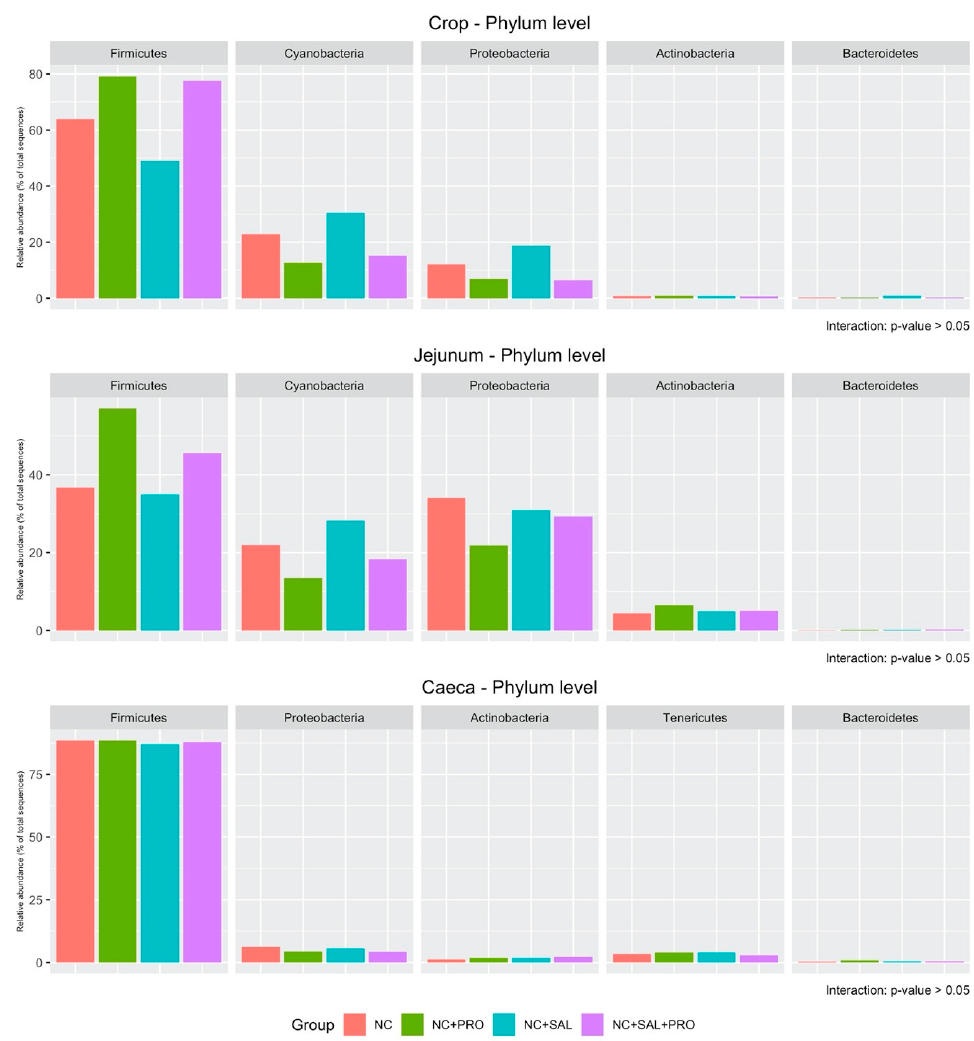
Figure 3. Relative abundance of dominant microbiota at the phylum level in the crop, jejunal, and cecal digesta samples: NC—control diet with no additives; NC + PRO— B. licheniformis preparation (1.6 × 10 9 CFU / kg diet); NC + SAL—salinomycin addition (60 ppm); NC + SAL + PRO—a mixture of salinomycin (60 ppm) and B. licheniformis (1.6 × 10 9 CFU / kg diet); means represent 10 pens of one chick each pooled by two ( n = 5).